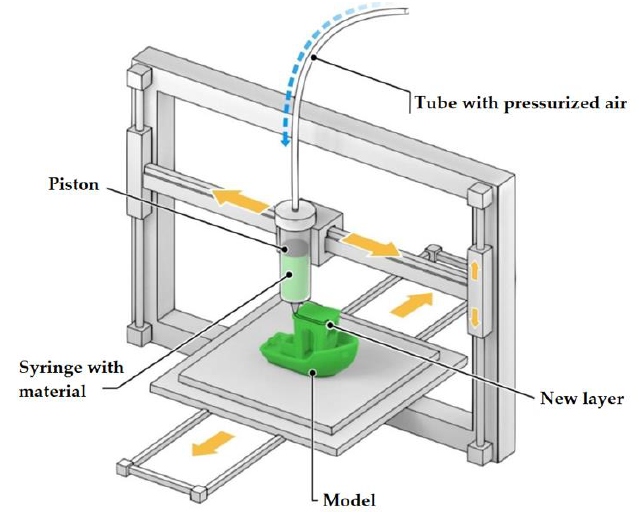
Figure 2. Direct printing method, a schematic diagram.